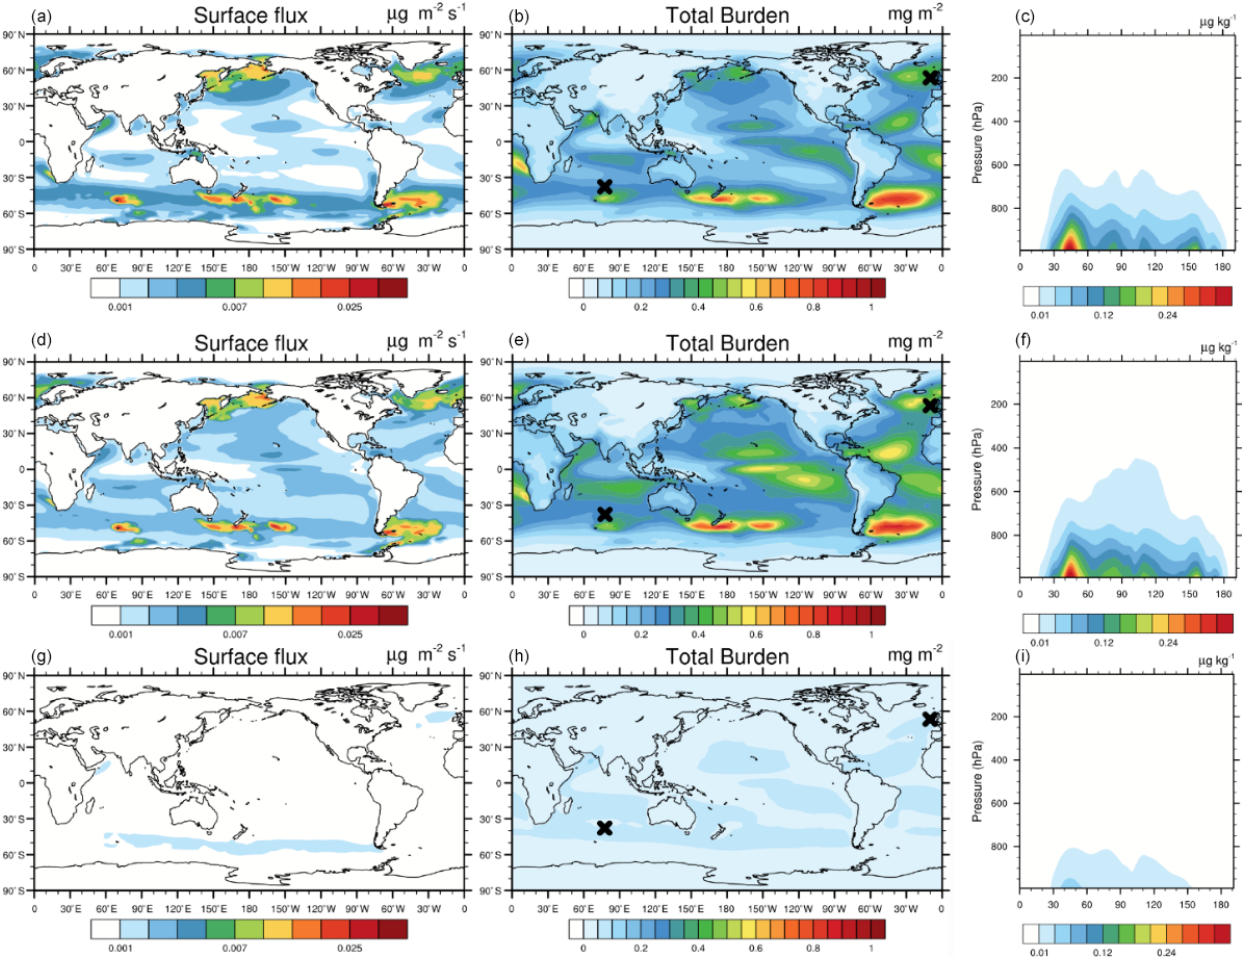
Figure 1. Spatial distributions of annual mean surface flux (first column, in units of µgm − 2 s − 1 ) and vertically integrated (column) burden of MOA (second column, in units of mgm − 2 ) and latitude–pressure cross sections of annual mean MOA mixing ratio (third column, in units of µgkg − 1 ) from the B14 (first row), G11 (second row), and NULL (third row) experiments. The right-hand black cross in the second row indicates the position of Mace Head, and the left-hand black cross indicates the position of Amsterdam